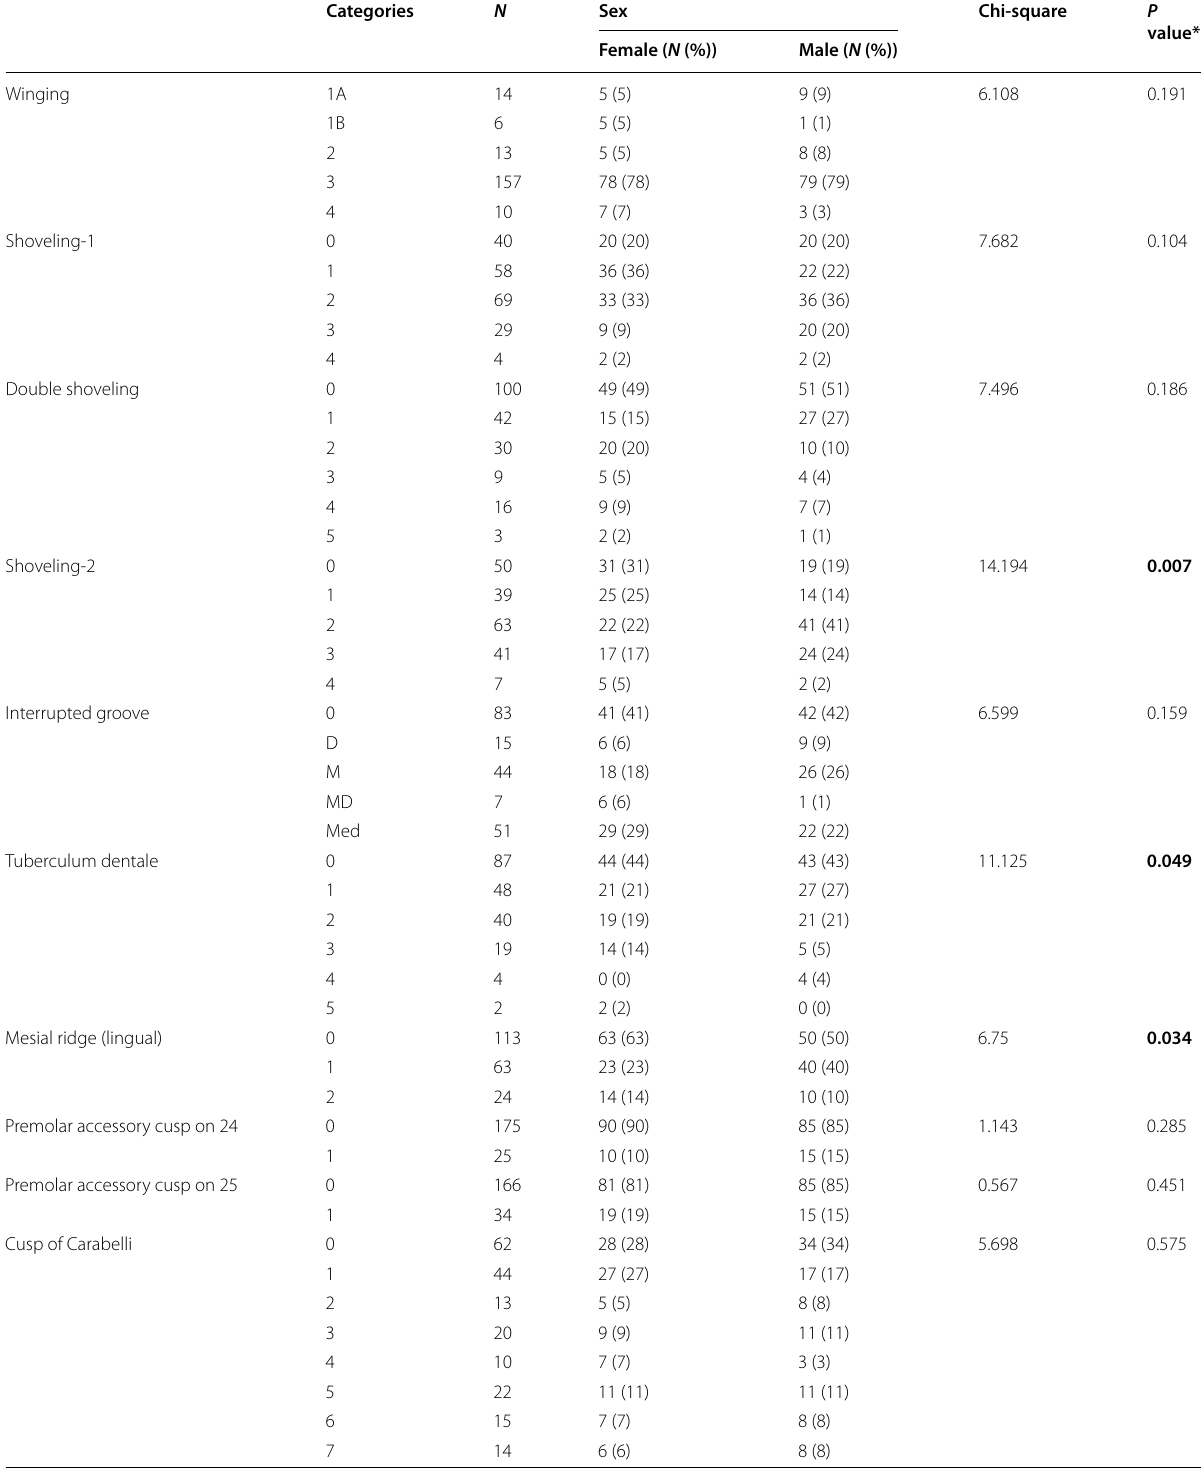
Table 5 Sexually dimorphic frequencies for expression of grade of non-metric trait and chi test